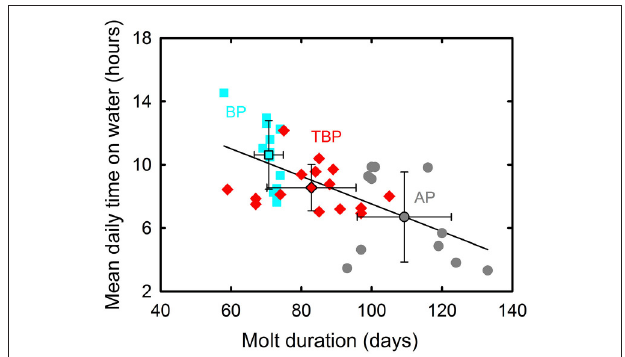
FIGURE 3 | Negative linear correlation between mean daily time on water and molt duration for individual Antarctic (gray) and thin-billed (red) prions and blue petrels (blue). Means ± SD are also indicated.